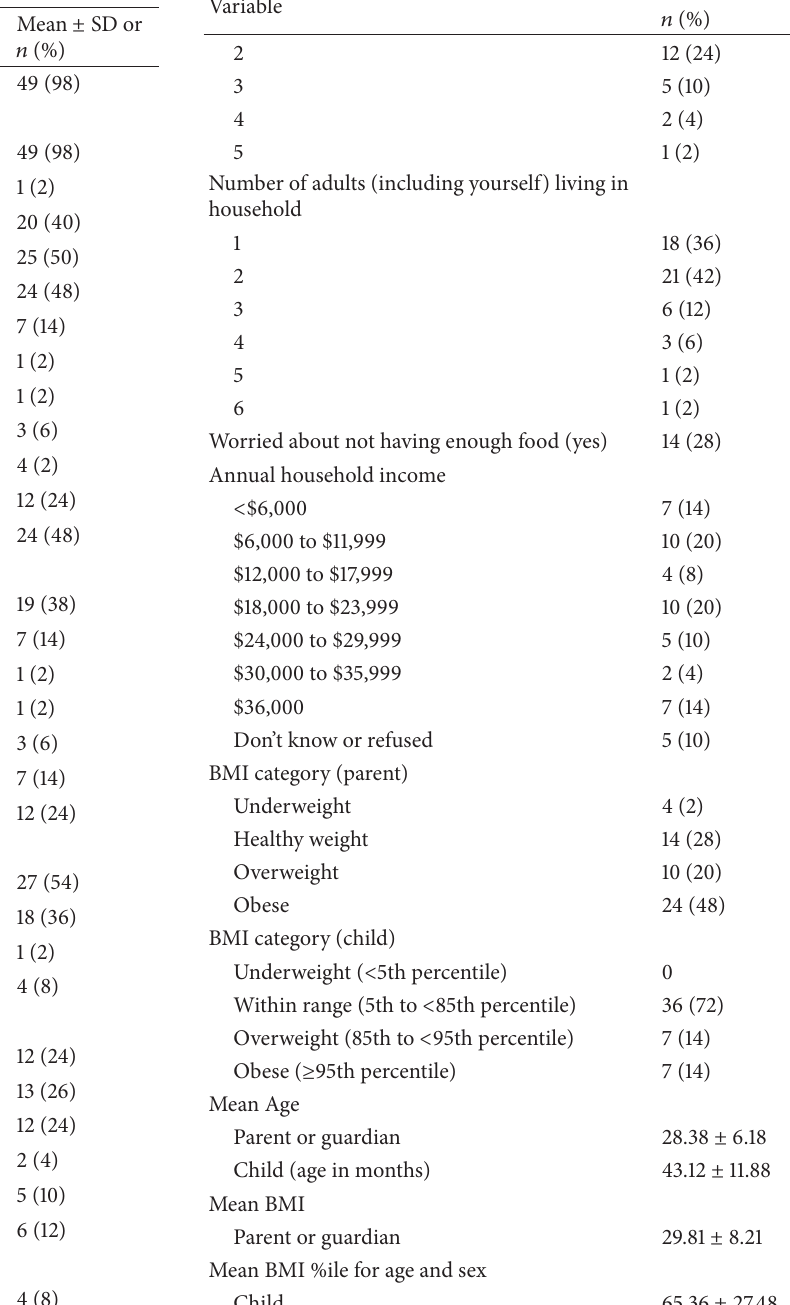
Table 1: Demographic characteristics of the 50 parent-child pairs in healthy homes, healthy